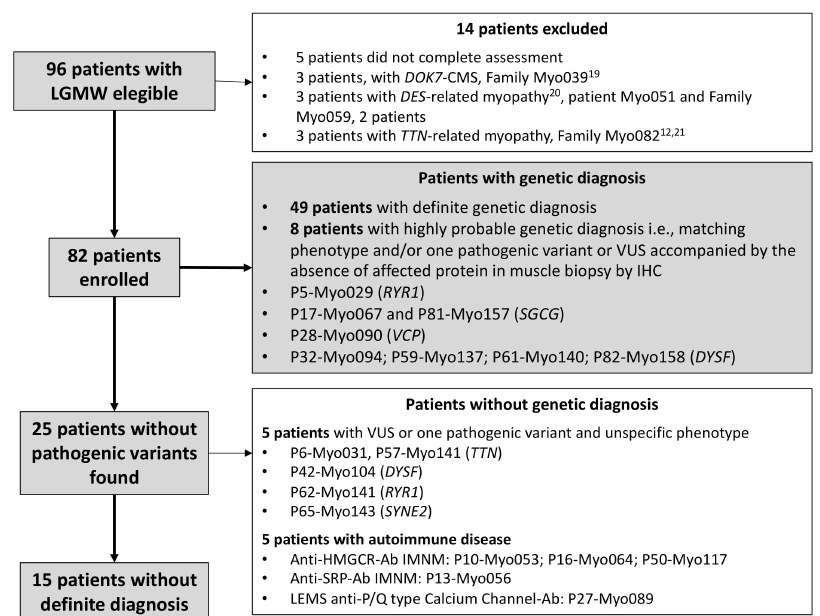
Figure 1. Patient selection strategy and study design. Grey boxes indicate the main flow of the protocol and patients with definite or highly probable genetic diagnosis. Patients excluded from the protocol or with no genetic diagnosis are shown in the white boxes. See also Table